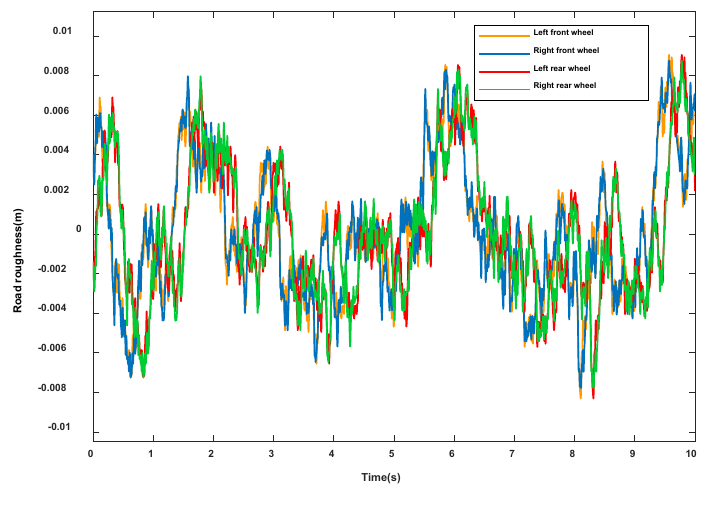
Figure 4. Pavement Figure 4. Pavement Incentives.